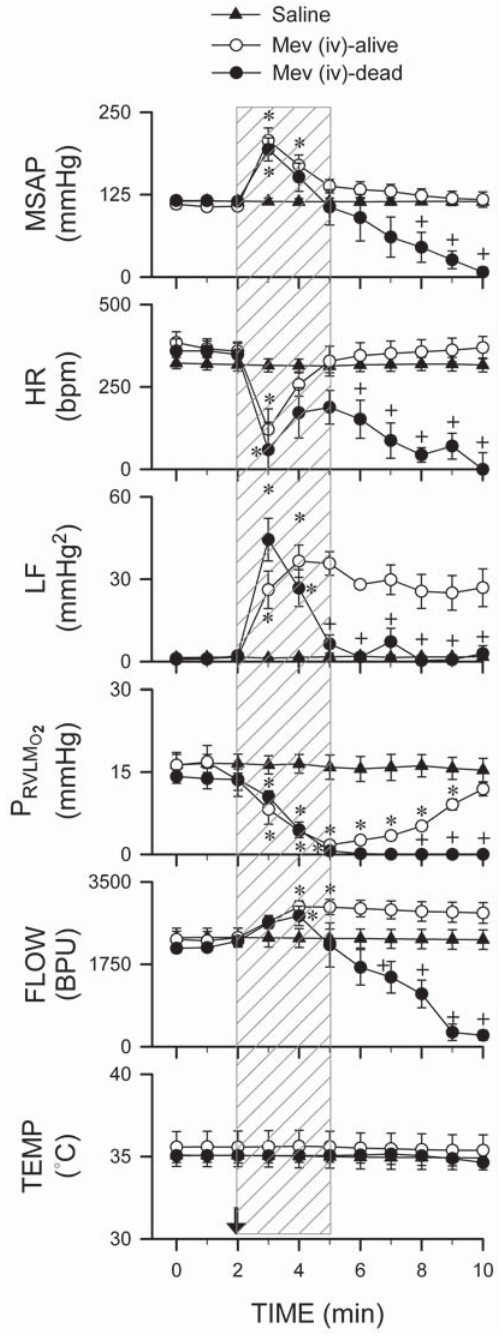
Figure 2. Loss of functional integrity because of anoxia in RVLM prevents resumption of spontaneous circulation after cardiac arrest. Temporal changes in mean SAP (MSAP), HR, power density of LF component of SAP spectrum, and tissue oxygen concentration, microvascular perfusion or temperature in RVLM of rats that survived or died of cardiac arrest induced by intravenous administration of Mev (1000 m g/kg; at arrow). Again, the vital time- window between cardiac arrest and resumption of spontaneous circulation during which anoxia took place in RVLM is demarcated by hatched bars. Values are mean 6 SEM of 5–7 animals per experimental group. * p , 0.05 versus saline group, and + p , 0.05 versus alive group at corresponding time-points in the post hoc Scheffe´ multiple-range analysis following two-way ANOVA.